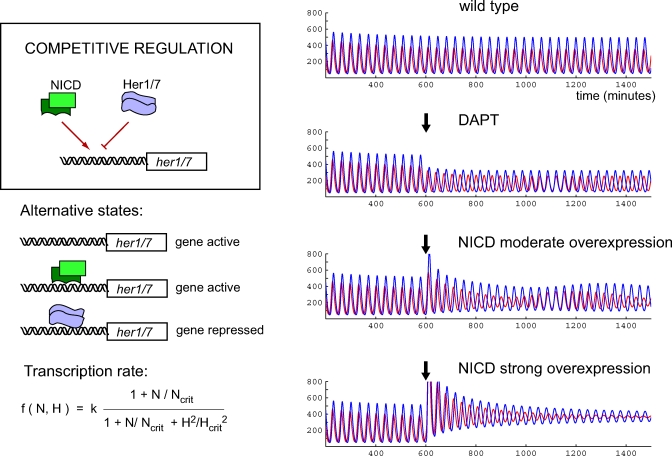
A Model of her1/7 Gene Regulation by NICD and Her1/7 Protein, and the Predictions That It MakesThe left column explains the basic hypothesis: NICD and Her1/7 protein compete to bind to a regulatory site of the her1/7 gene. The function f (N,H) describes the resulting dependence of the rate of transcription of her1/7 on the concentrations N and H of NICD and Her1/7 monomers respectively (see text and Text S1). The right column shows the predicted behaviour of the model when a perturbation is abruptly imposed at the time indicated by the arrow. The red and blue lines show the computed oscillating levels of expression of Her1 protein in two neighbouring cells whose free-running rhythms differ in period by 10%. In the “wild-type” condition, where Notch signalling operates normally, the two cells are entrained to oscillate in synchrony. In the “DAPT” condition, where Notch signalling is defective, synchrony is gradually lost. When a moderate uniform constitutive level of NICD (2 × Ncrit, see Text S1) is superimposed on the endogenous production, synchrony is again lost, and complex variations of expression amplitude occur in the long term. Finally, when a very high uniform constitutive level of NICD (20 × Ncrit) is superimposed on the endogenous production, synchrony is lost and the oscillations are severely damped.